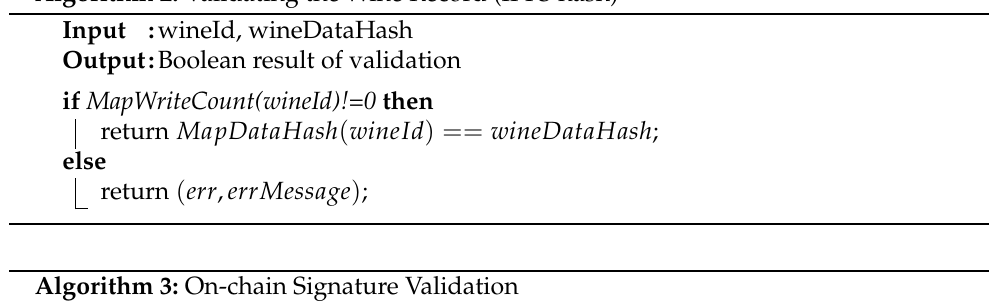
Algorithm 2: Validating the Wine Record (IPFS hash)